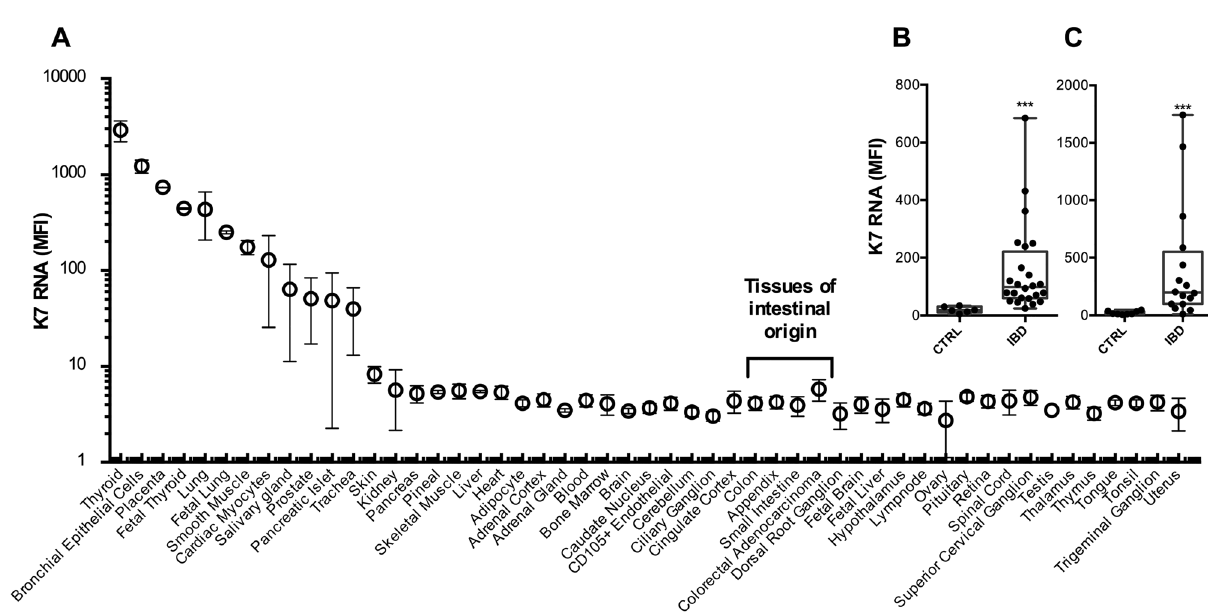
Figure 3. K7 mRNA is expressed in inflamed colon but not in healthy colon. ( A ) According to the tissue- specific mRNA expression in bulk RNAseq, dataset published by Su et al. 2004, K7 mRNA (probe 209016_s_at) is not found at detectable levels in samples of intestinal origin. ( B , C ) K7 mRNA is significantly upregulated in the colon of IBD patients. Data was downloaded from publicly available transcriptomes ( B Arijs et al. 2009, E-GEOD-14580; C , Galamb et al. 2008, E-GEOD-4183) which include in total samples from both IBD patients (N = 40) and healthy controls (N = 14), where one dot represents a single individual. Boxes extend from 25 to 75th percent, line inside shows median value and whiskers min and max values. Statistical significance was measured by ( B , C ) Mann–Whitney test. *P < 0.05; ***P <